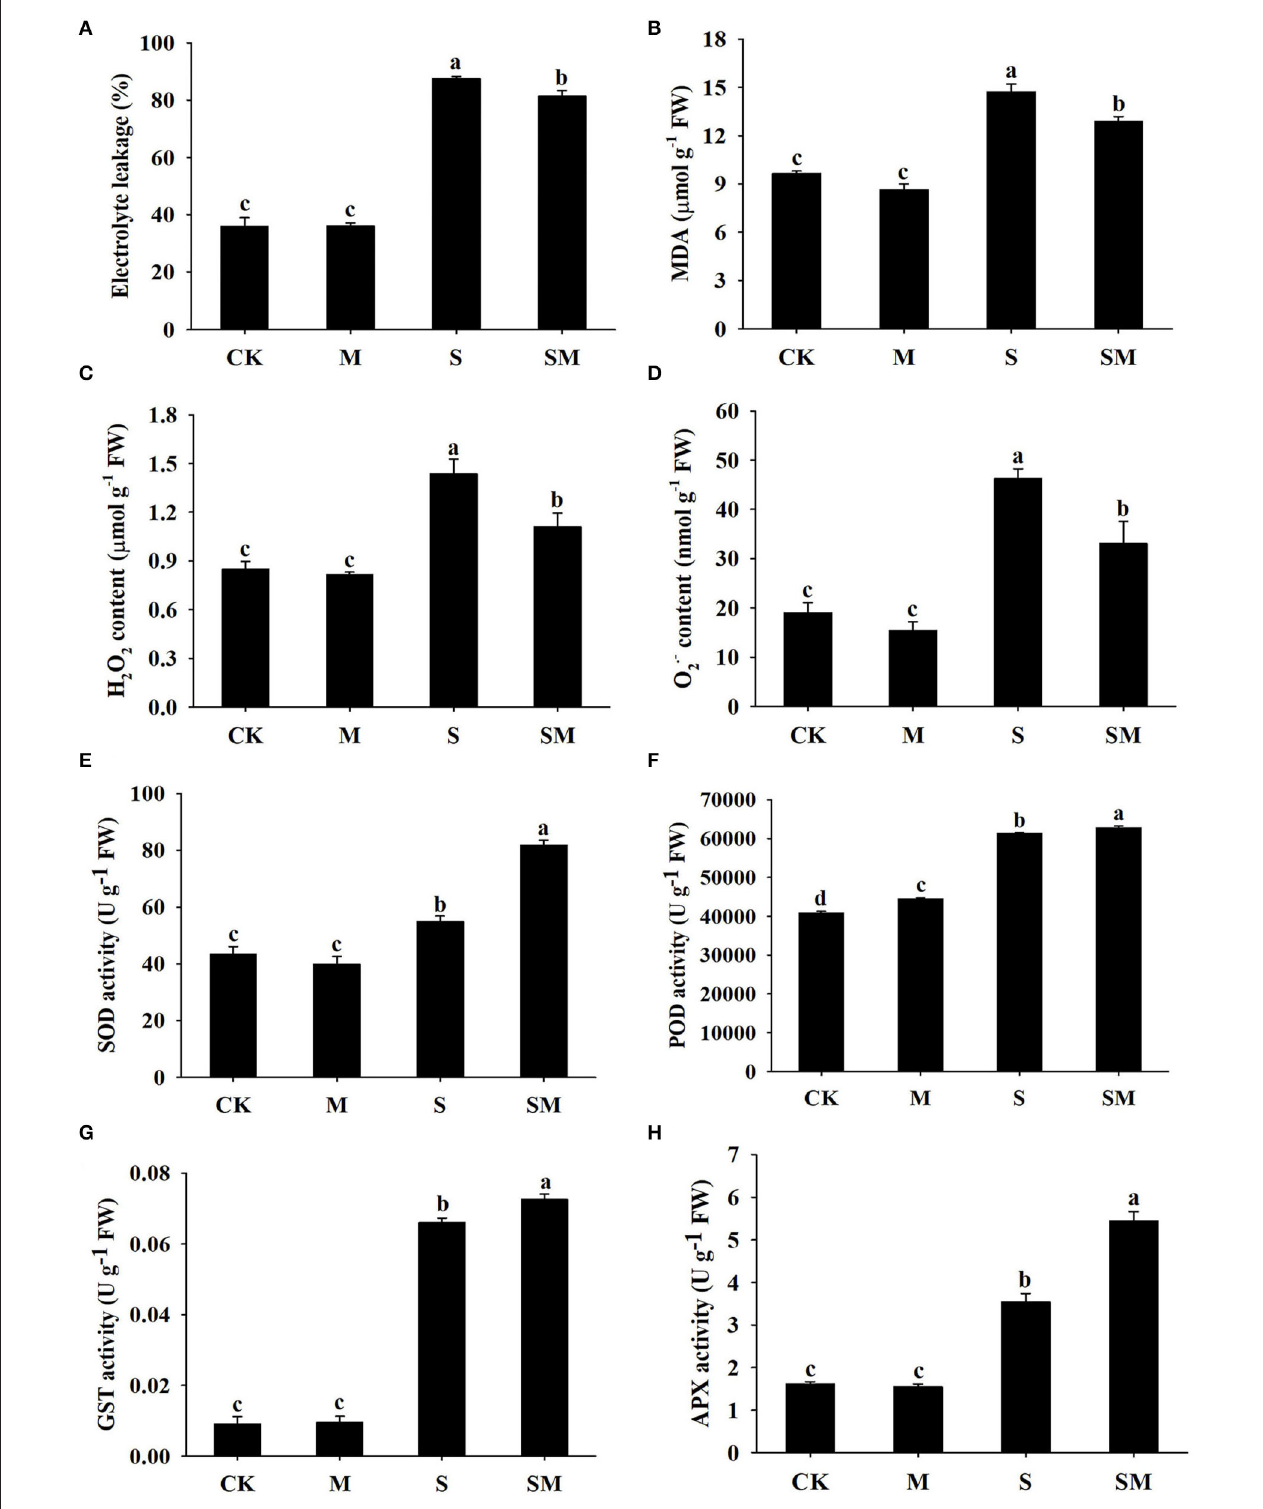
FIGURE 2 | Effect of exogenous melatonin on (A) electrolyte leakage, (B) MDA content, (C) H 2 O 2 content, (D) O . − 2 content, (E) SOD, (F) POD, (G) GST, and (H) APX of alfalfa seedlings after 15 days of 150-mM NaCl treatment. Data are means ± SE ( n = 3) and different letters are significantly different ( p < 0.05).